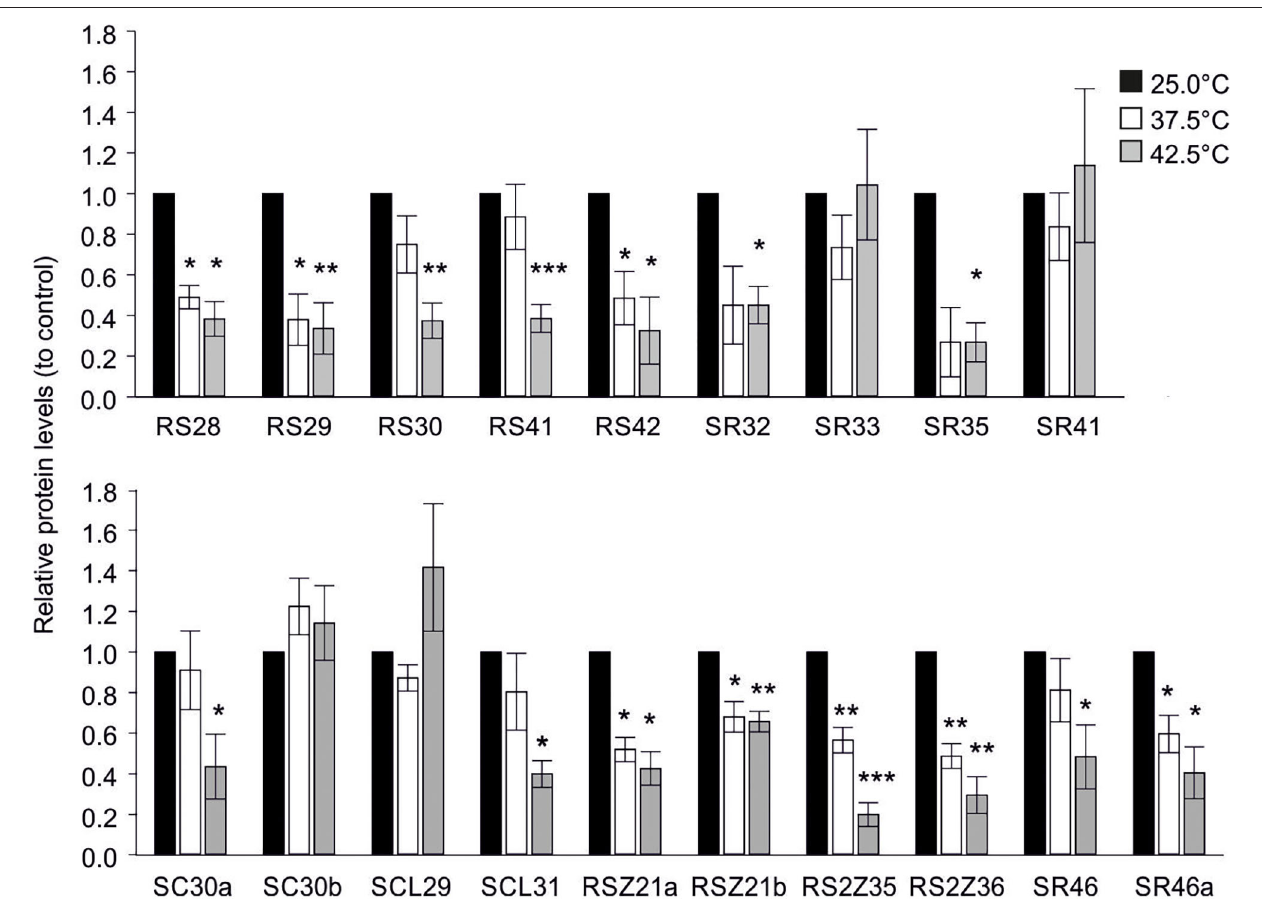
FIGURE 8 | Effect of high temperatures on protein abundance of HA-tagged SR proteins in tomato protoplasts. HA-tagged SR and SR-like proteins were expressed in tomato protoplasts for 5h, followed by exposure to the indicated temperatures for 1h. Protein levels were analyzed by quantification of signals using ImageJ 1.53 ( Schindelin et al., 2012), following immunodetection with α HA antibody. Values are the average of 3 independent experiments with error bars indicating ± SE. For each experiment, the signal intensities were first normalized against the endogenous Hsc70 and then to the 25 ◦ C sample. Asterisks indicate statistically significant difference between treated (37.5 or 42.5 ◦ C) and control sample (25 ◦ C) based on paired t -test comparison (* p < 0.05, ** p < 0.01, *** p < 0.001). Representative immunoblots can be found in Supplementary Figure 5